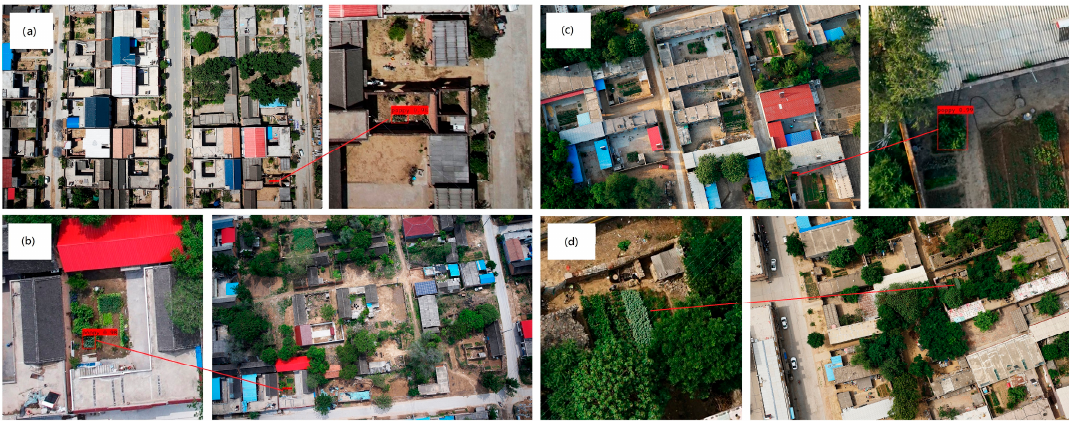
Figure 15. Partial test results for complete unmanned aerial vehicle (UAV) images: ( a , b ) the true detection; ( c ) false detection; ( d ) missed detection.